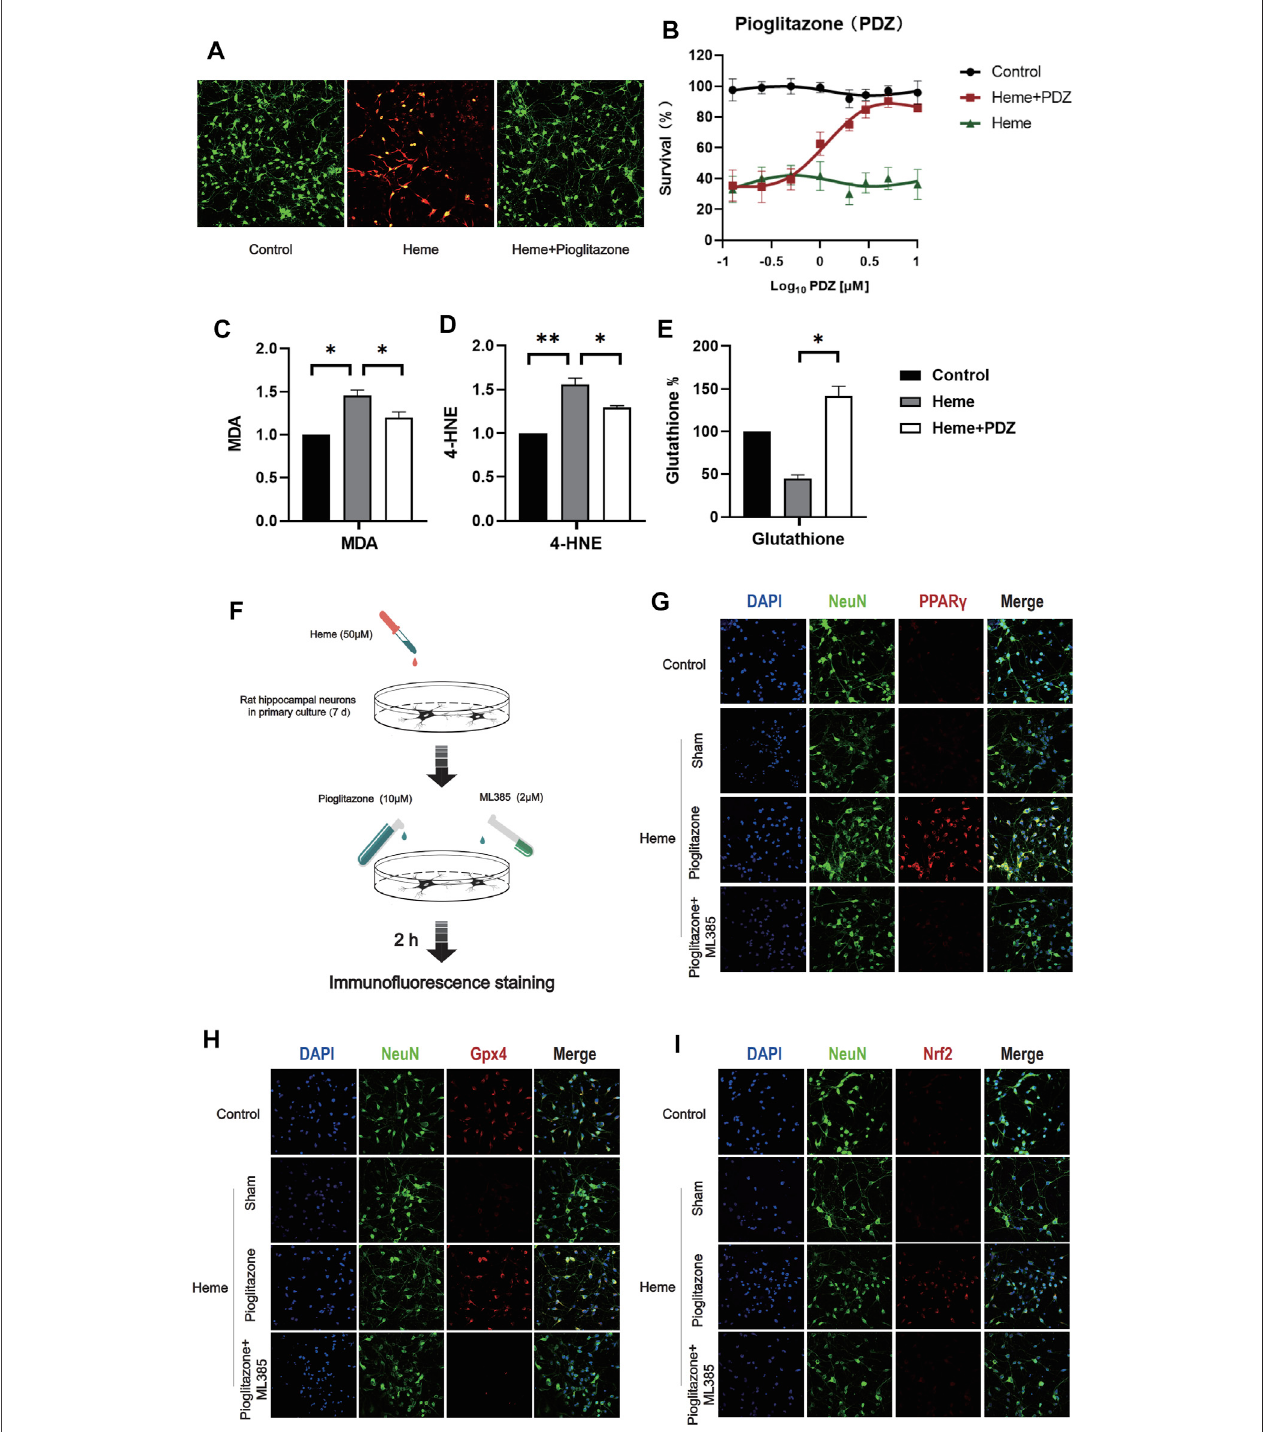
FIGURE 3 | PPAR γ activation inhibits heme-induced neuronal ferroptosis in vitro by activating Nrf2. (A) After 7 days of culture, rat primary hippocampal neurons wereusedforthecell survival/death analysis(green fl uorescent cellslabeled withcalcein-AMwerealive,and red fl uorescentcells labeled withethidium homodimerwere dead).Then,representativeimageswerecapturedusingaconfocal fl uorescencemicroscope. (B) The fl uorescenceintensityofCCK-8stainingwasdetectedat450 mm usingamicroplatereader. (C) AkitwasusedtodetecttheMDAcontentineachgroupofneurons. (D) 4-Hydroxynonenal(4-HNE)contentineachgroupofcells.